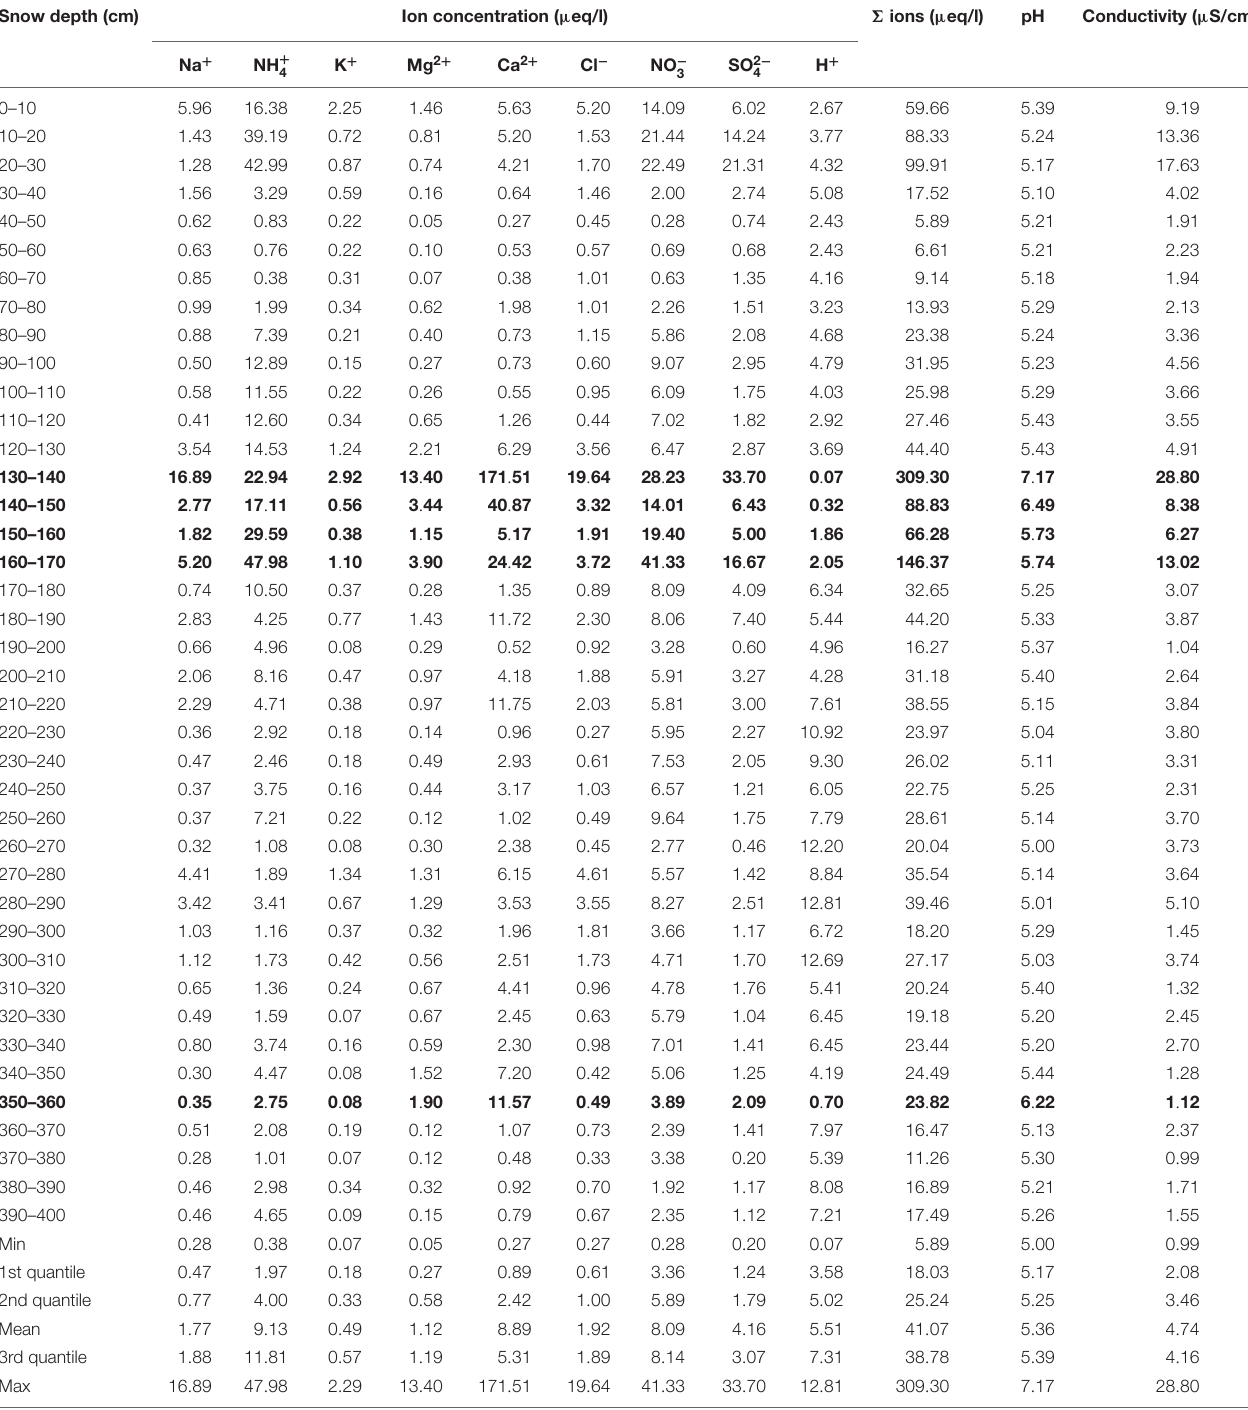
TABLE 1 | Ion concentrations, pH, conductivity, and ion sum of every single 10 cm increments of the snow pack from the accumulation period September 2015 to April 2016. Snow depth (cm) Ion concentration ( µ